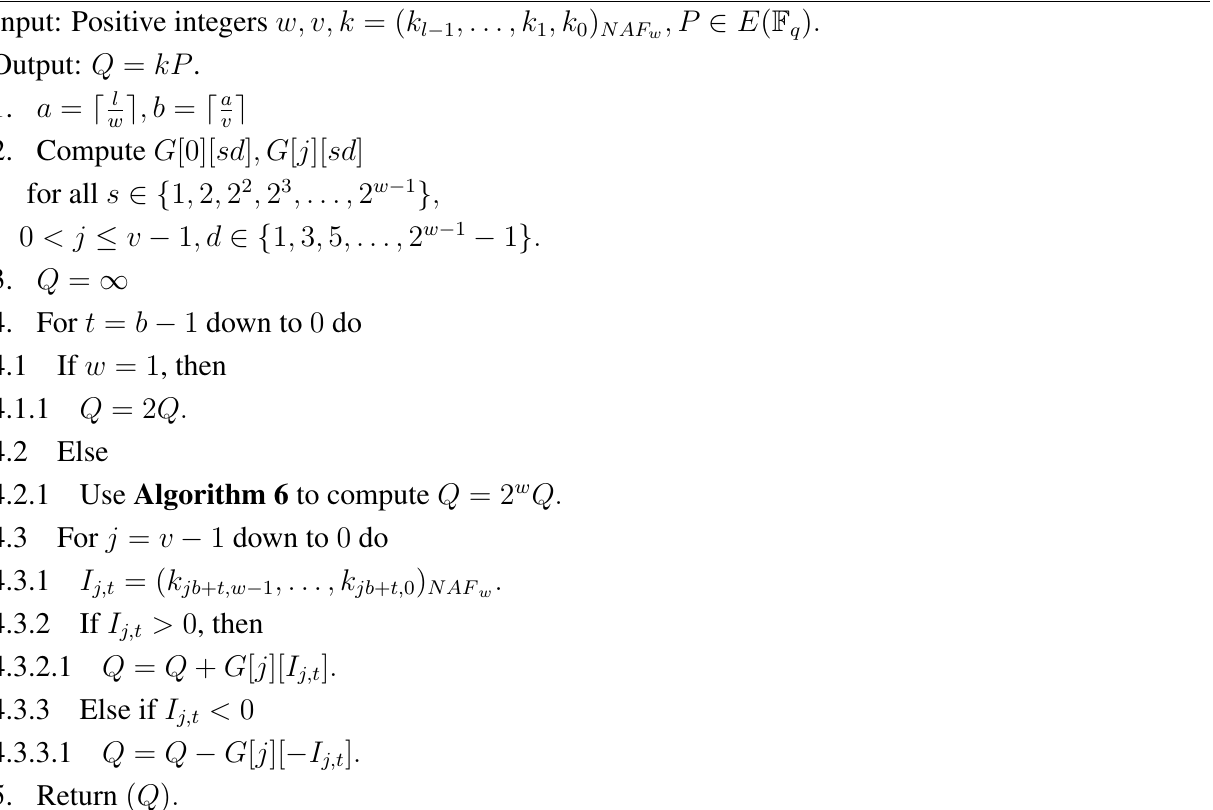
Algorithm 7. Mohamed, Hashim and Hutter’s method for scalar